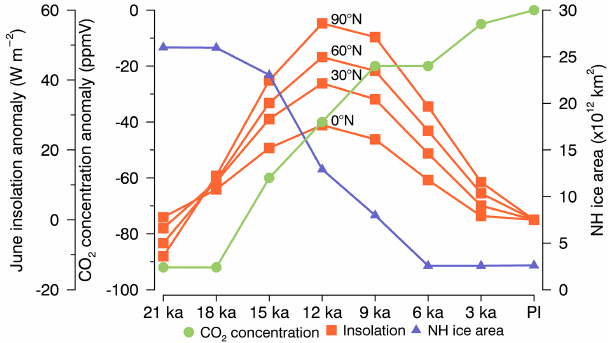
Figure 1. Boundary conditions for the time slice simulations. CO 2 concentrations are relative to the PI concentration of 280ppmV. NH ice area is the total area covered by the continental ice sheets. June insolation anomalies are relative to PI at the indicated latitude. Mid- month insolation data from Berger and Loutre